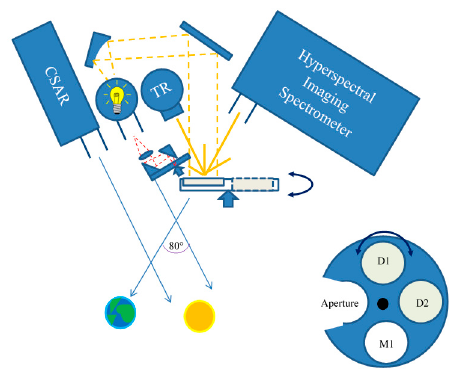
Figure 12. Lamp illuminates the diffuser via the integrating sphere and mirrors to provide calibration of the HIS at intermediate wavelengths.